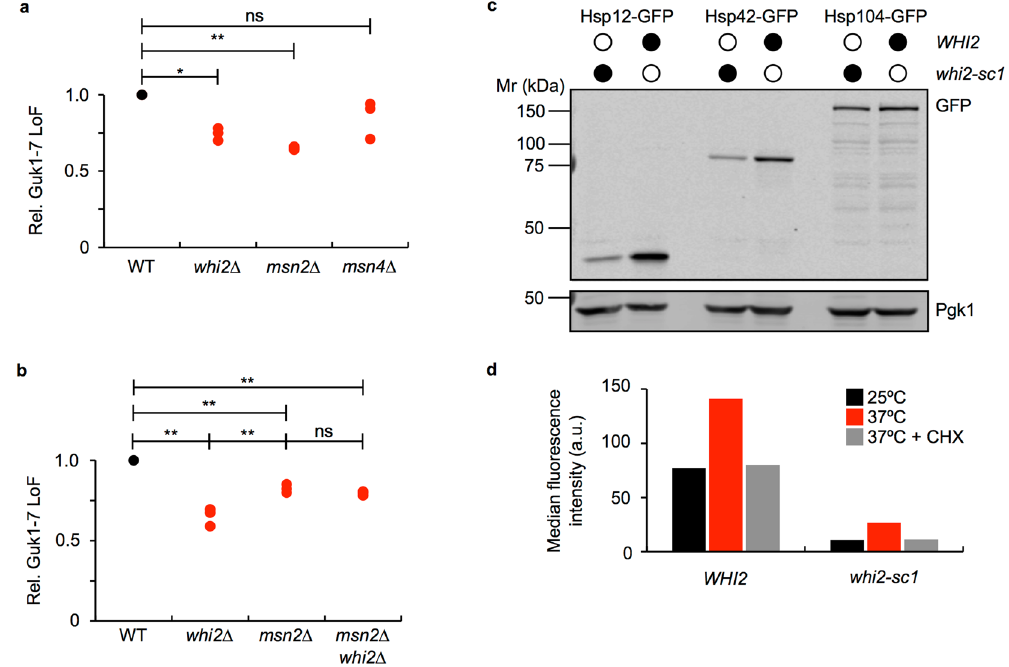
Figure 5. Msn2 is linked to reduced proteostatic capacity in WHI2 mutants. ( a ) Wild type, whi2 ∆ , msn2 ∆ , and msn4 ∆ cells expressing Guk1-7-GFP were analysed by flow cytometry following a two hour incubation at 25°C or 37°C in the presence of CHX. P values were calculated with a one-way ANOVA and post-hoc Tukey HSD to assess significance ( * , ** , and ns denote p < 0.05, 0.01, and not significant, respectively). ( b ) Wild type, whi2 ∆ , msn2 ∆ , and msn2 ∆ whi2 ∆ cells expressing Guk1-7-GFP were analysed by flow cytometry following a two hour incubation at 25°C or 37°C in the presence of CHX. P values were calculated with a one-way ANOVA and post-hoc Tukey HSD to assess significance ( ** and ns denote p < 0.01 and not significant, respectively). ( c ) WHI2 and whi2-sc1 strains with either Hsp12, Hsp42, or Hsp104 endogenously tagged with GFP were grown at 25°C. Membranes were immunoblotted with an anti-GFP antibody and an anti-Pgk1 antibody as a loading control. ( d ) WHI2 and whi2-sc1 strains with Hsp12 endogenously tagged with GFP were grown to log phase and then incubated at 25°C, 37°C, or 37°C in the presence of CHX for 2 hours prior to anlysis by flow cytometry. Uncropped images for all Western blots can be found in Supplementary Fig.